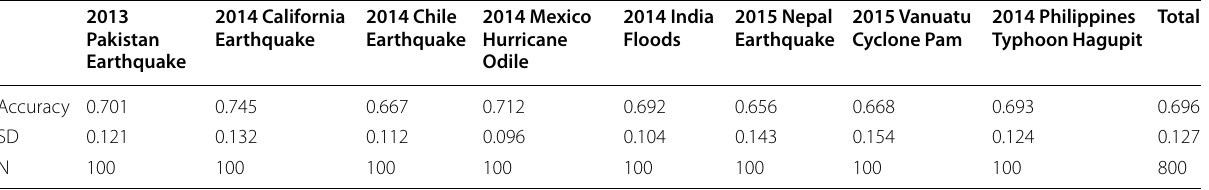
SD Standard Deviation